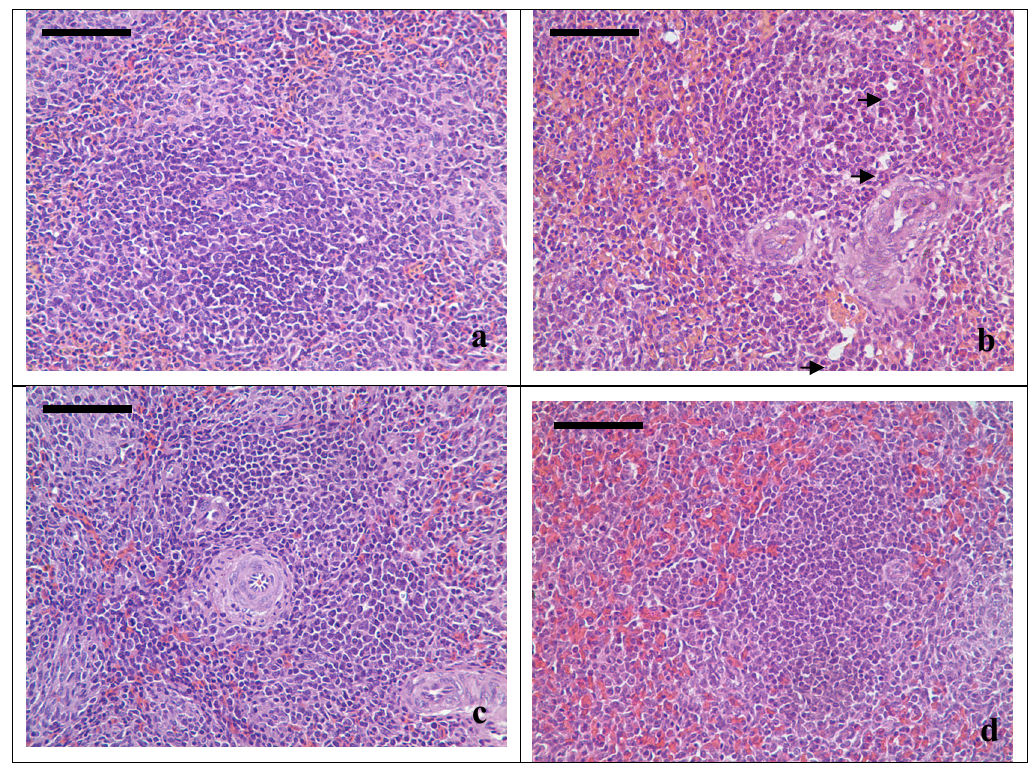
Figure 1. ( a ) Spleen of the 21-day-old chickens in the control group. ( b ) Spleen of a 21-day-old chicken in the AFB group. In the periarterial lymphatic sheath, the number of 1 lymphocytes was decreased and vacuoles appeared (arrows), congestion in red pulp was observed. ( c ) Spleen of a 21-day-old chicken in the +Se group II. There were no obvious changes compared with control group. ( d ) Spleen of a 21-day-old chicken in the +Se group